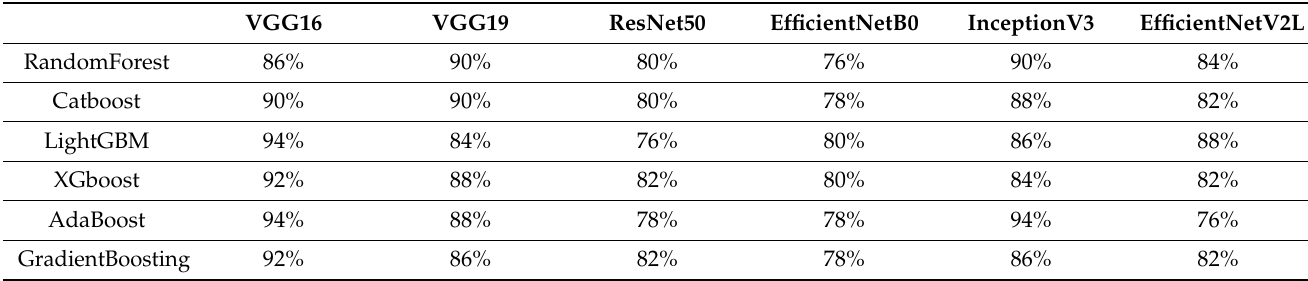
Table A13. Accuracy of each model combination for green triangles.